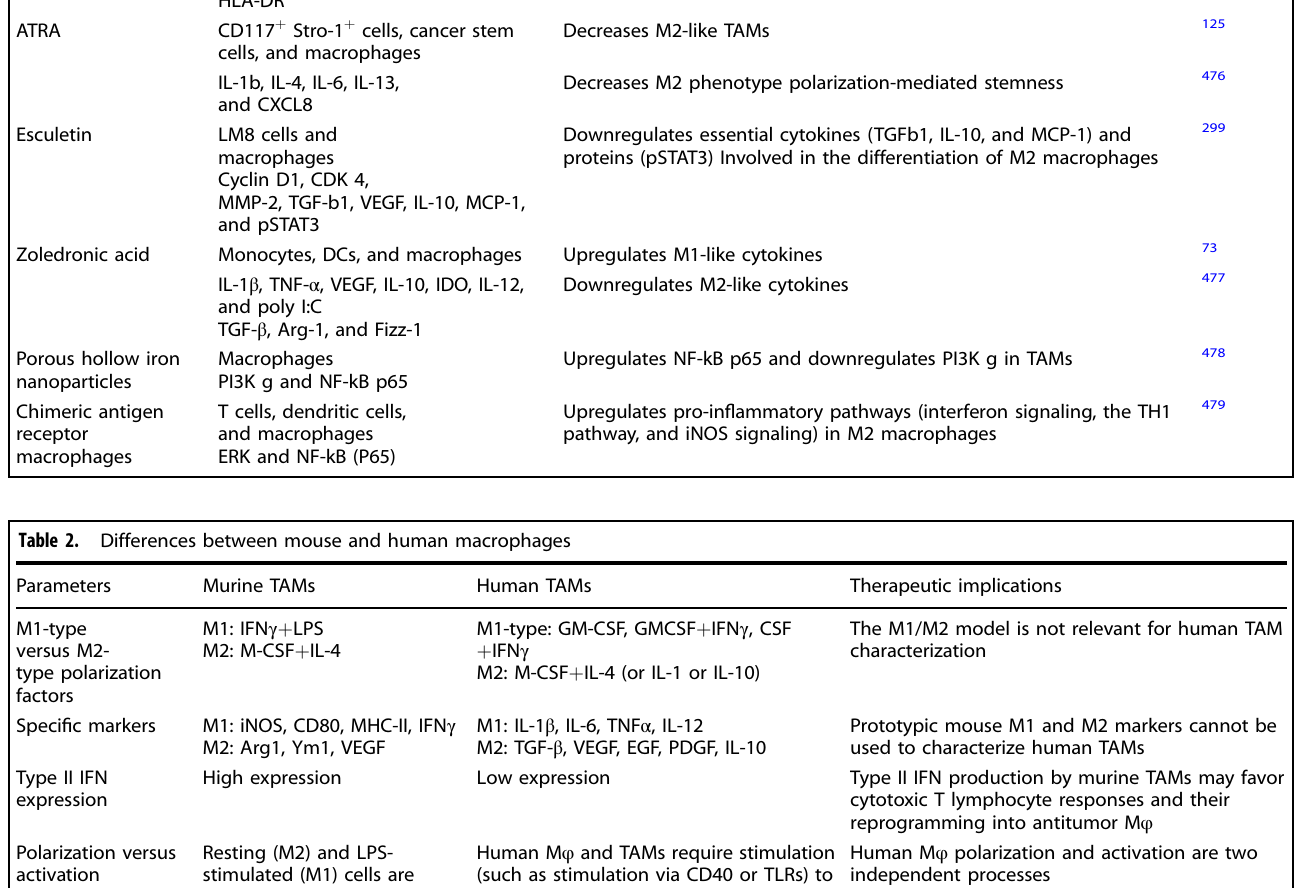
Table 1). We have also highlighted the differences between human and murine TAMs (summarized in Table 2). Overall, with the deepening understanding of TAMs, investigators will have the option to manipulate TAMs using various approaches to enhance osteosarcoma immunotherapy.